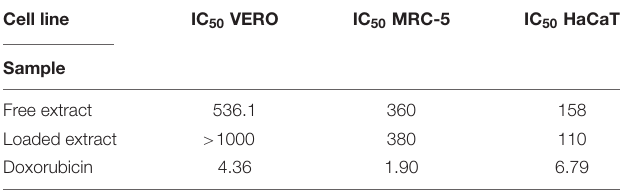
TABLE 5 | Biological assessments for the toxicity of the free and loaded extract of A. urundeuva leaves in different cell lines as assessed by IC 50 values of the free and loaded extract in comparison to doxorubicin (used as